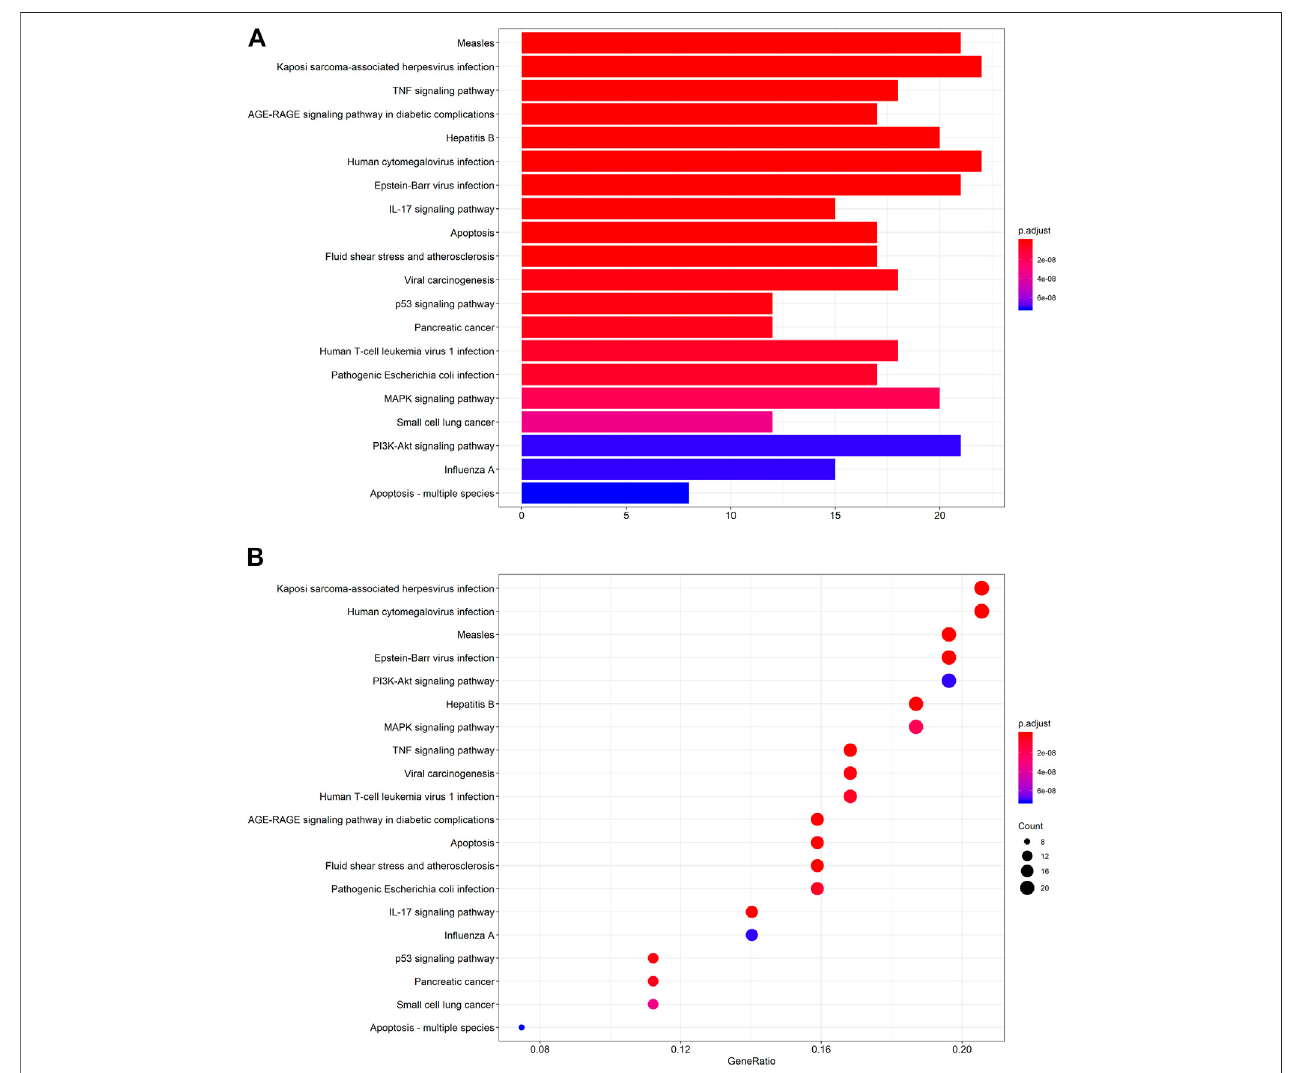
FIGURE 3 | KEGG pathway enrichment analysis of the active compounds of Cornus of fi cinalis and Paeonia lacti fl ora. (A) Bar plot of top 20 enriched pathways of KEGG analysis, ranked by enrichment score. The intensity of the colors represents the adjusted p -value. (B) Bubble plot displaying the top 20 enriched pathways of KEGG analysis, ranked by gene count. The intensity of the colors represents the adjusted p -value and the bubble size corresponds to the number of genes.